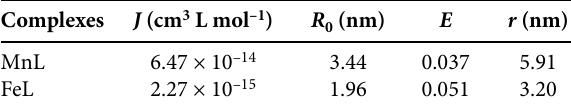
Table 4: Energy transfer parameters for the interaction of metal complexes with BSA Complexes